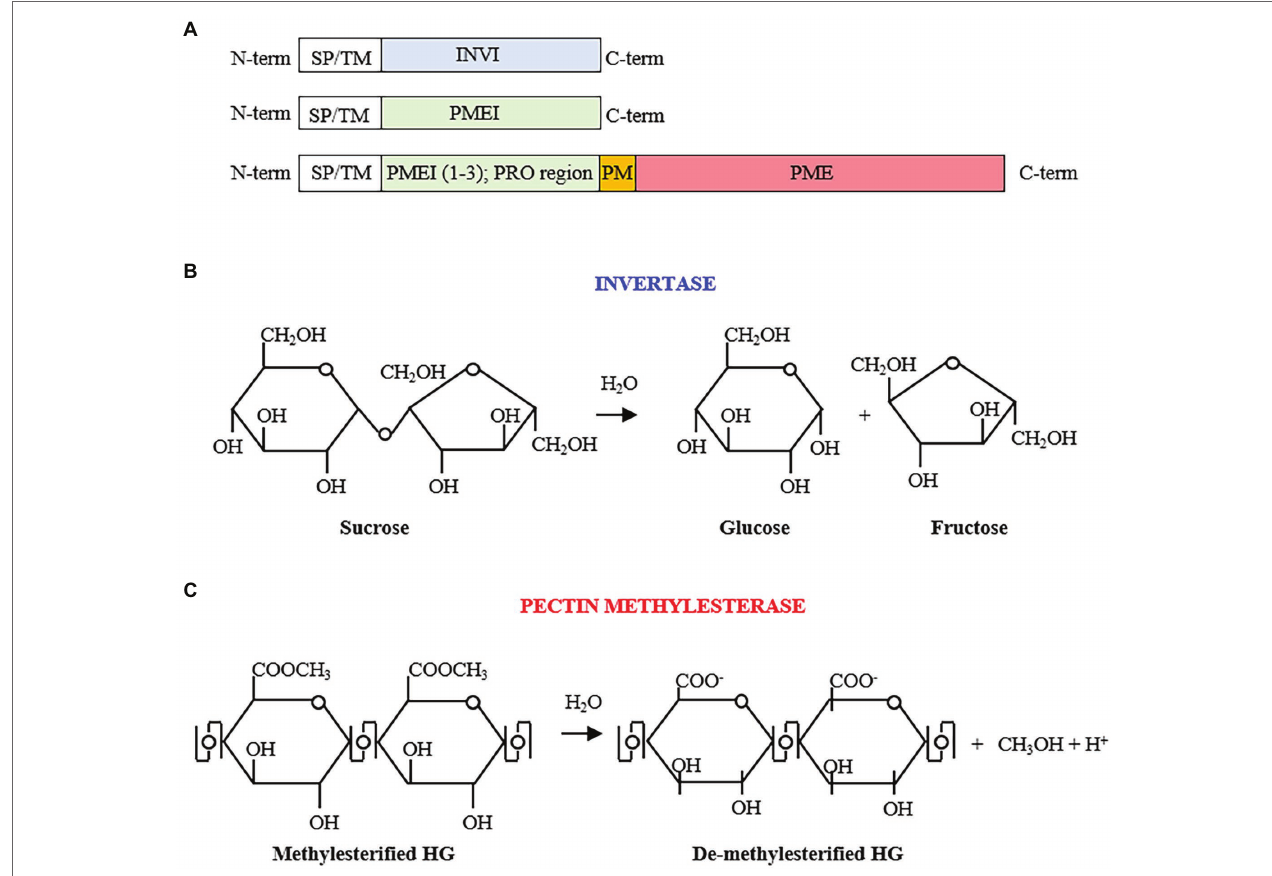
FIGURE 1 | (A) Invertase inhibitor (INVI) and pectin methylesterase inhibitor (PMEI) structural organizations. The INVI/PMEIs domain are preceded by a signal peptide (SP) or a transmembrane domain (TM) for the targeting to the endomembrane system leading to the different subcellular localization. PMEI/INVIs can possess one, both, and neither of these motifs. Some PMEIs (from 1 to 3 isoforms; also named PRO region) can be clustered with a C-terminal PME. (B) Sucrose hydrolysis by invertase activity yielding glucose and fructose. (C) De-methylesterification of homogalacturonan (HG) by pectin methylesterases, with consequent production of negatively charged carboxyl groups, methanol, and